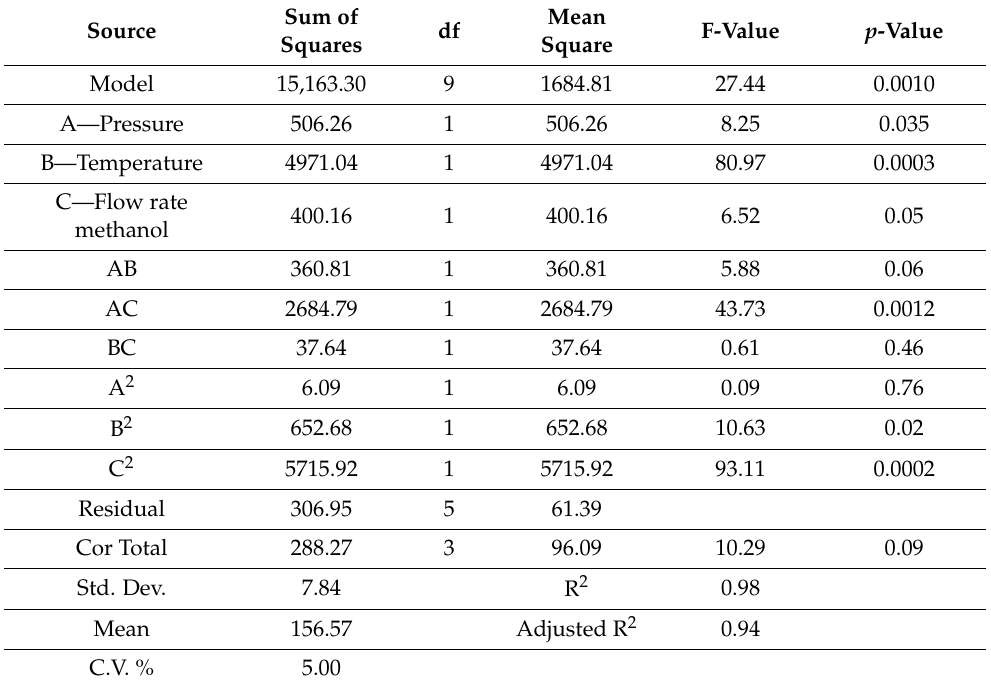
Table 2. ANOVA table of catechin recovery by